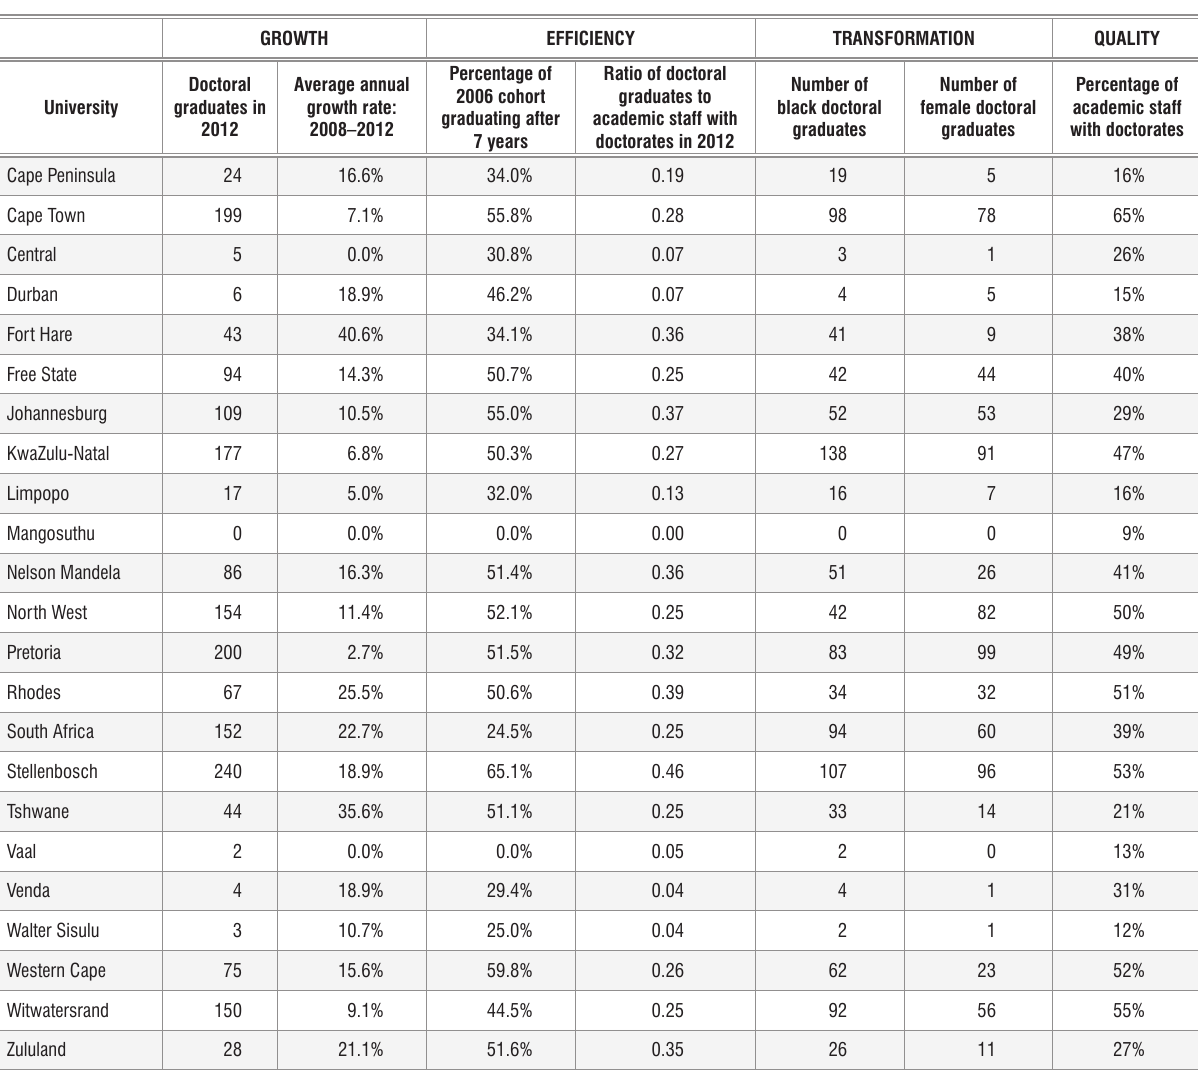
Indicators for performance in doctoral production GROWTH EFFICIENCY